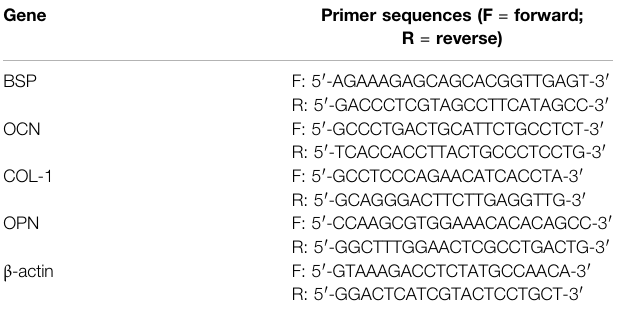
TABLE 1 | Primer sequences utilized for RT-PCR. Gene Primer sequences (F = forward;